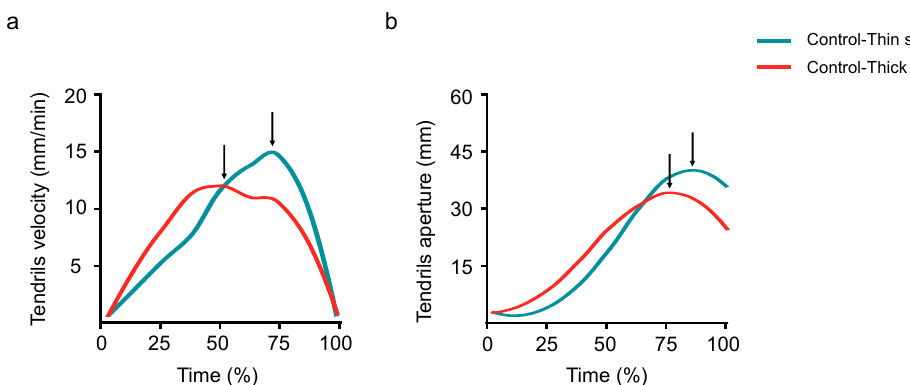
Figure 5. A graphical representation of the velocity of the tendrils ( a ) and of their aperture ( b ) for the ‘Control-Thin’ (i.e., the light blue line) and the ‘Control-Thick’ conditions (i.e., the red line). The arrows indicate the moments when the maximum peak velocity ( a ) and the maximum peak aperture ( b ) occurred. Please note that these peaks occurred earlier for the ‘Control-Thick’ than for the ‘Control-Thin’ conditions.